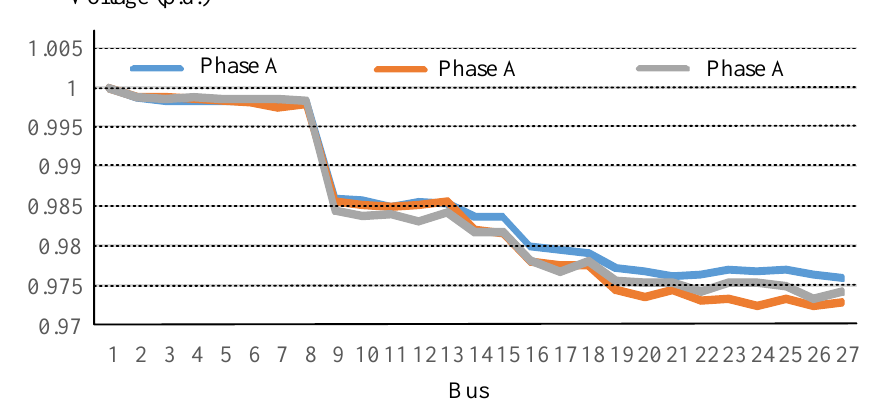
Figure 7. The three-phase voltage profiles of each bus after the phase rearrangement at the heavy load period.